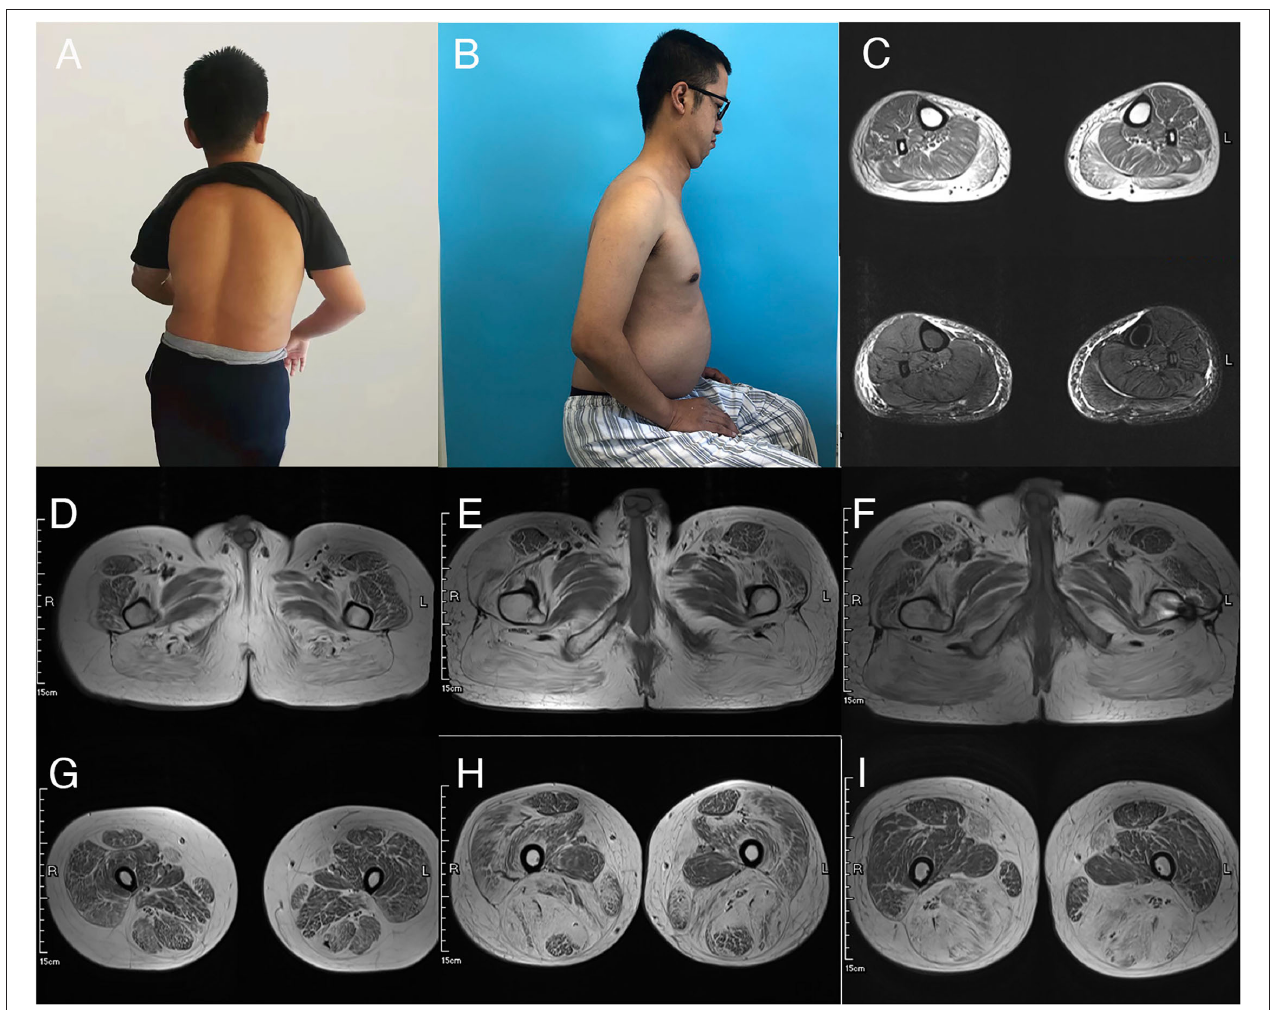
FIGURE 1 | MRI findings of the thigh and photographs of patients. Scoliosis in patient one and rigid spine in patient two were showed in (A,B) . (C) Showed adipose infiltration of bilateral gastrocnemius in patient three in T2-weighted image (T2WI) (upper) and fat-saturated T2-weighted sequence (lower). Abnormal signals in bilateral gluteus maximus and subcutaneous adipose accumulation were revealed in patient one (D) , patient two (E) , and patient three (F) . MRI of the thigh muscle of patient 1 showed overall thigh muscle mass atrophy and diffused abnormal signal. Bilateral sartorius was the most severely involved and almost replaced by adipose tissue (G) . Patient two showed massive involvement of thigh muscles (H) with overall fat infiltration, except the rectus femoris and adductor longus. The quadriceps involvement was severe and asymmetrical, left more than right. Thigh muscles from patient three showed severe fat infiltration particularly in the posterior compartment and bilateral sartorius. Other muscles were relatively preserved (I)